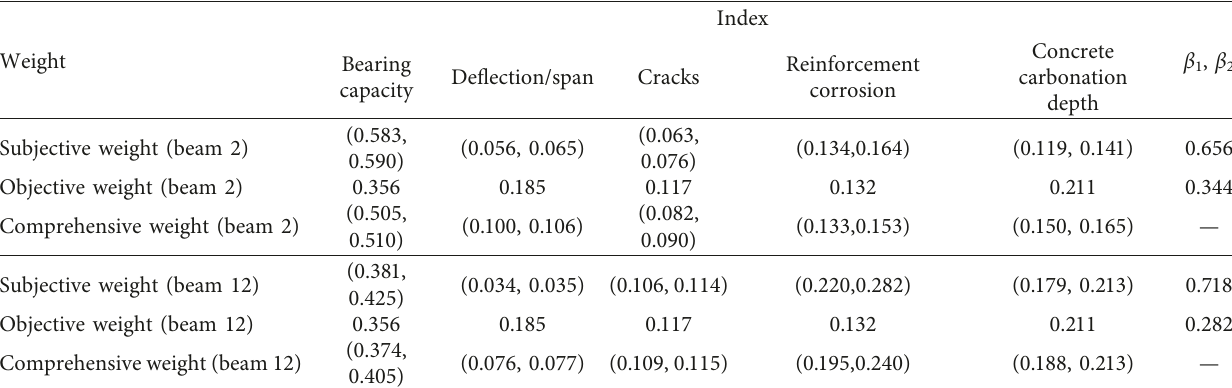
Table 7: Index weights calculated by the three